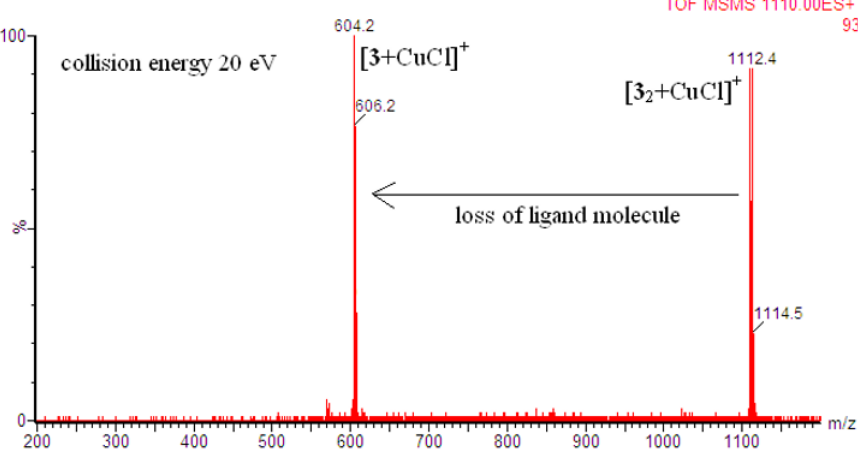
Figure 3. CID MS/MS spectrum of ion [3